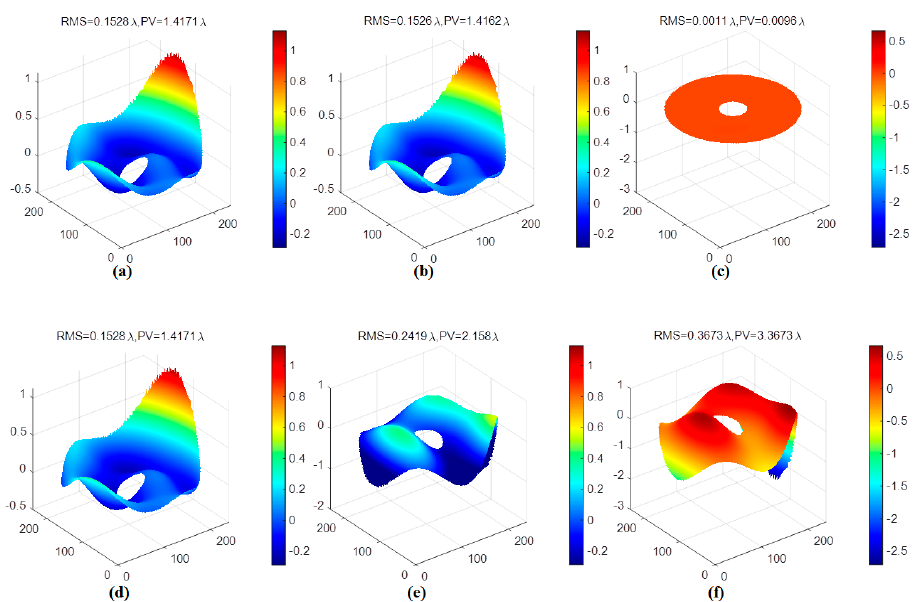
Figure 8. ( a ) The incident wavefront. ( b ) The restored wavefront by the ELM model. ( c ) The residual wavefront of the ELM model. ( d ) The incident wavefront. ( e ) The restored wavefront by the classical modal algorithm. ( f ) The residual wavefront of the classical modal algorithm.